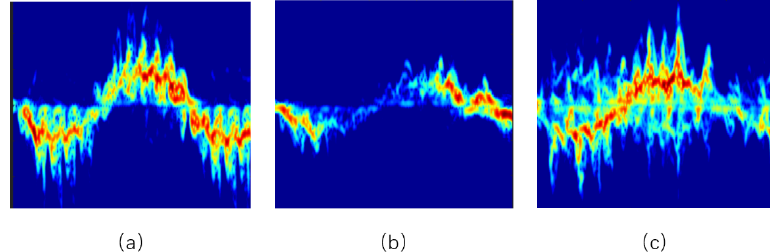
Figure 19. Comparison of spectrograms between recorded walking samples of different subjects: ( a ) well-recorded sample ( b ) uncomplete sample ( c ) noise